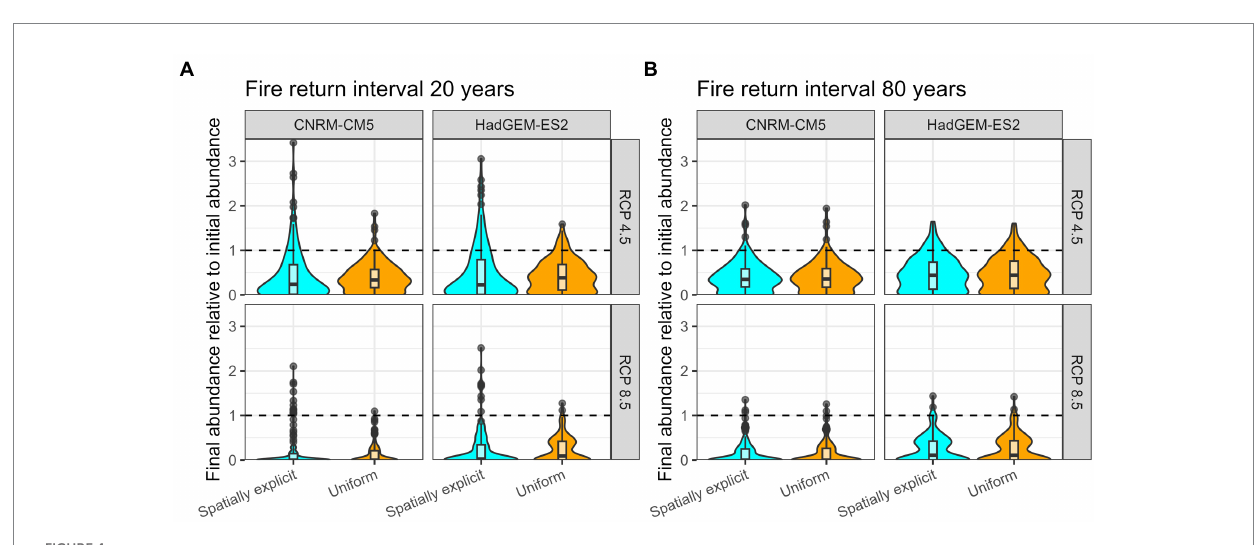
FIGURE 4 Final abundance of each subpopulation relative to the initial abundance of the subpopulation across different mean fire return intervals (A/B) , spatial patterns in fire frequency (color), climate model (columns), and emissions scenario